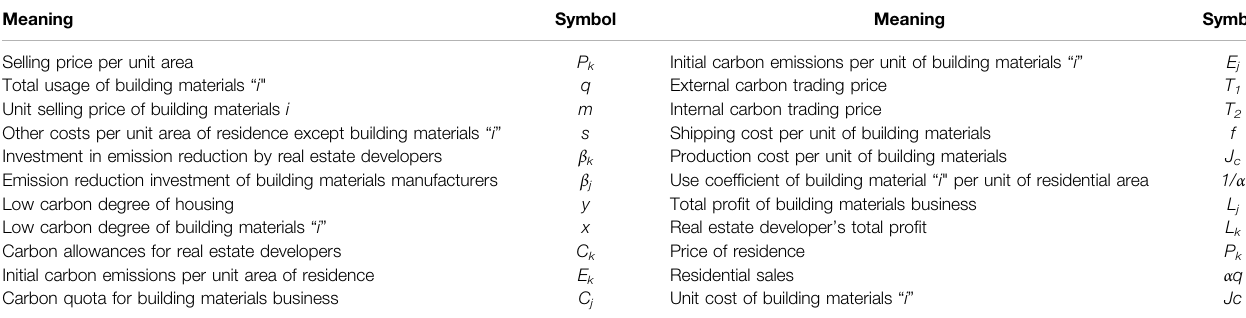
TABLE 1 | Details of main variables.